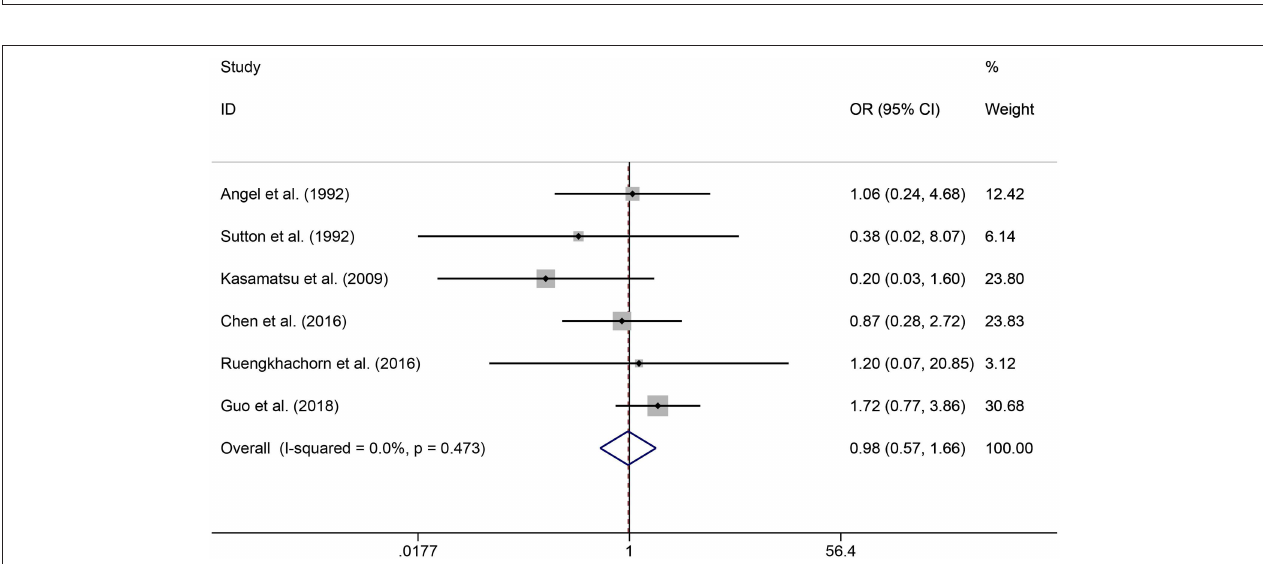
FIGURE 2 | Forest plots of OS for ovarian preservation vs. oophorectomy in early stage cervical adenocarcinoma. Weights were from fixed-effects model.